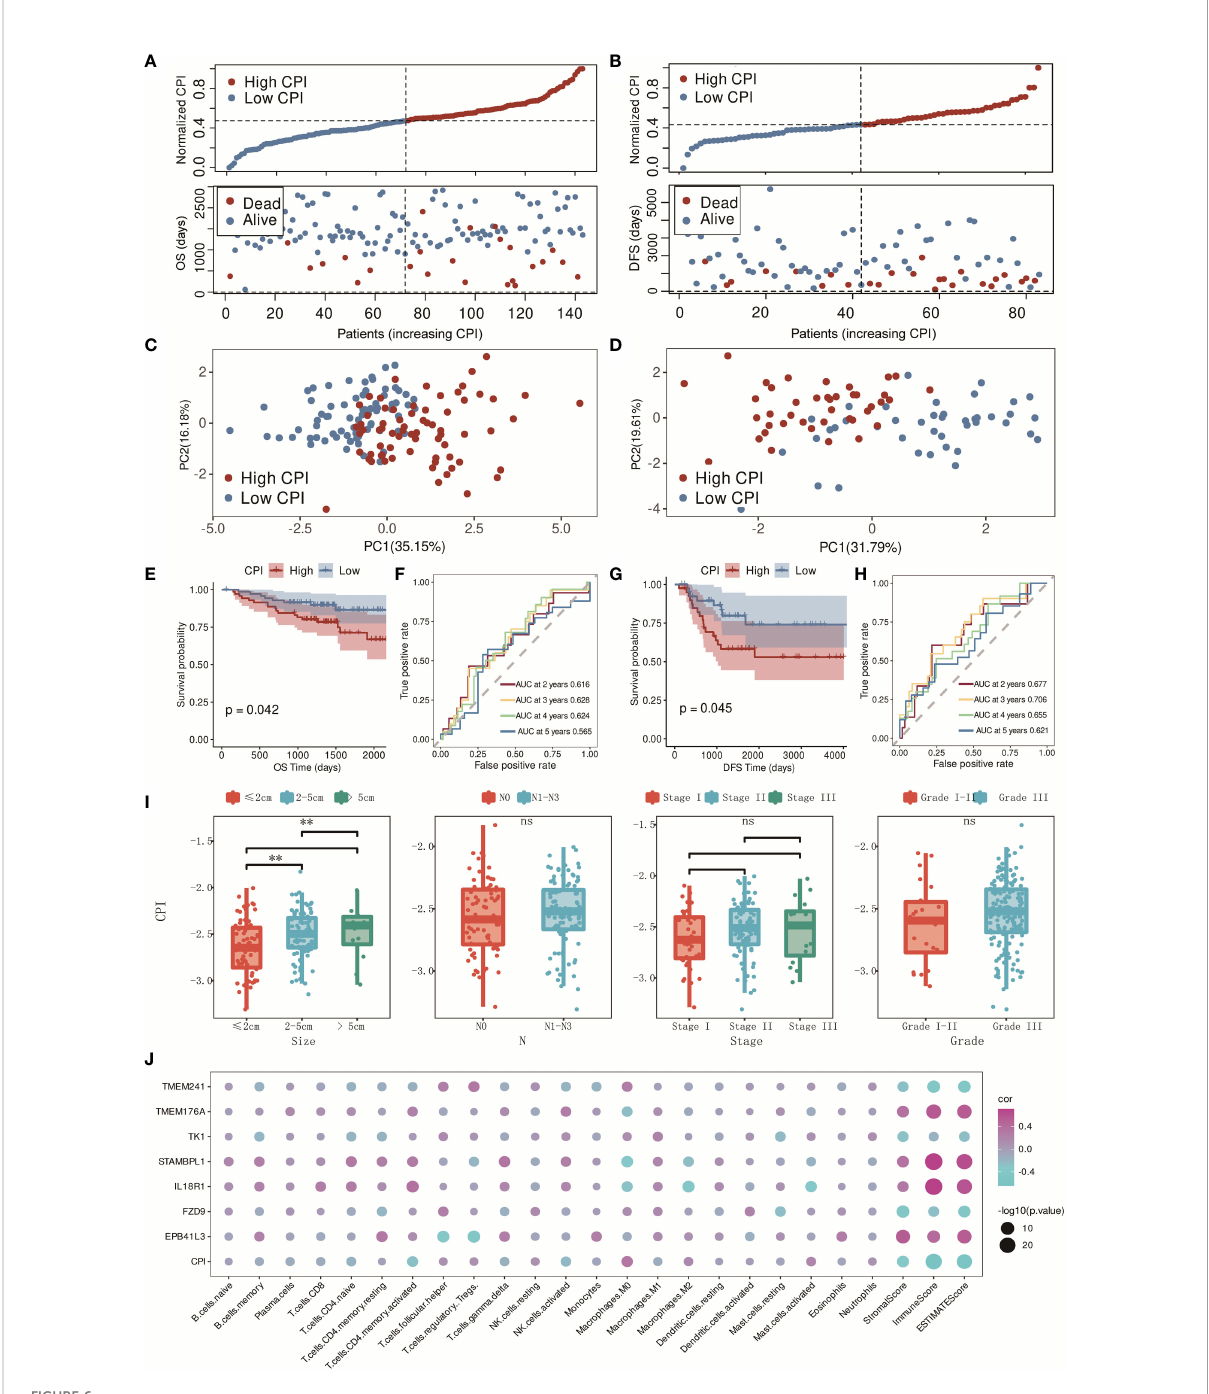
FIGURE 6 Validation of the CPI in GSE96058 and GSE21653 cohorts. (A) Distribution of adjusted CPI based on the CPI groups in the GSE96058 validation cohort. (B) Distribution of adjusted CPI based on the CPI groups in the GSE21653 validation cohort. (C) PCA plot in the GSE96058 validation cohort ( fi rebrick: high CPI; steel blue: low CPI). (D) PCA plot in the GSE21653 validation cohort ( fi rebrick: high CPI; steel blue: low CPI). (E) K-M survival analysis of the patients in the GSE96058 validation cohort ( fi rebrick: high CPI; steel blue: low CPI). (F) ROC curve analysis according to the 2-, 3-, 4-, and 5-year survival of the AUC value in the GSE96058 validation cohort. (G) K-M survival analysis of the patients in the GSE21653 validation cohort ( fi rebrick: high CPI; steel blue: low CPI). (H) ROC curve analysis according to the 2-, 3-, 4-, and 5-year survival of the AUC value in the GSE21653 validation cohort. (I) Relationships between CPI groups and clinical features (ns means no signi fi cance, and ** means p < 0.01). (J) Relationships between model genes, CPI, and TME characteristics (purple: positive correlation; blue: negative